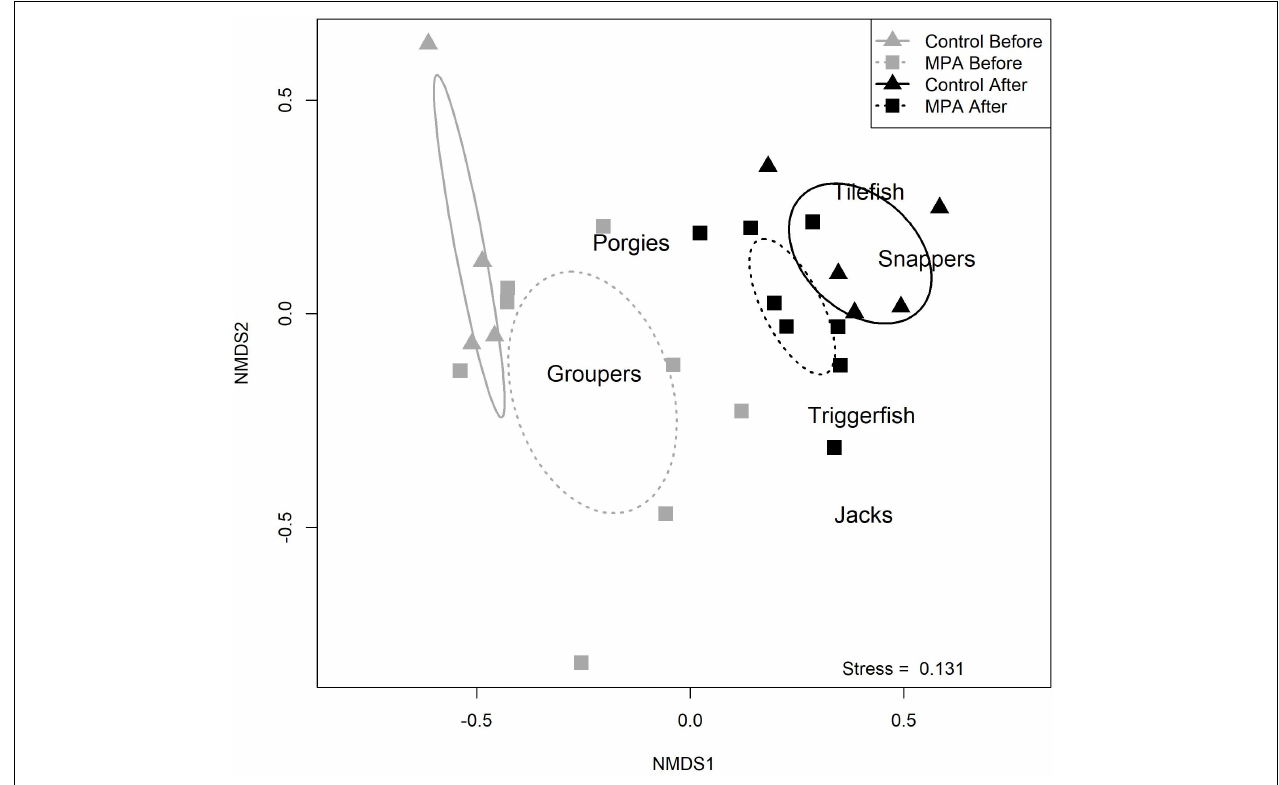
FIGURE 4 | Results of non-metric multidimensional scaling (NMDS) comparing reef fish communities in the two areas (Snowy Wreck Marine Protected Area and control) and time periods (before and after). A stress value of 0.131 indicates a fair to good fit.